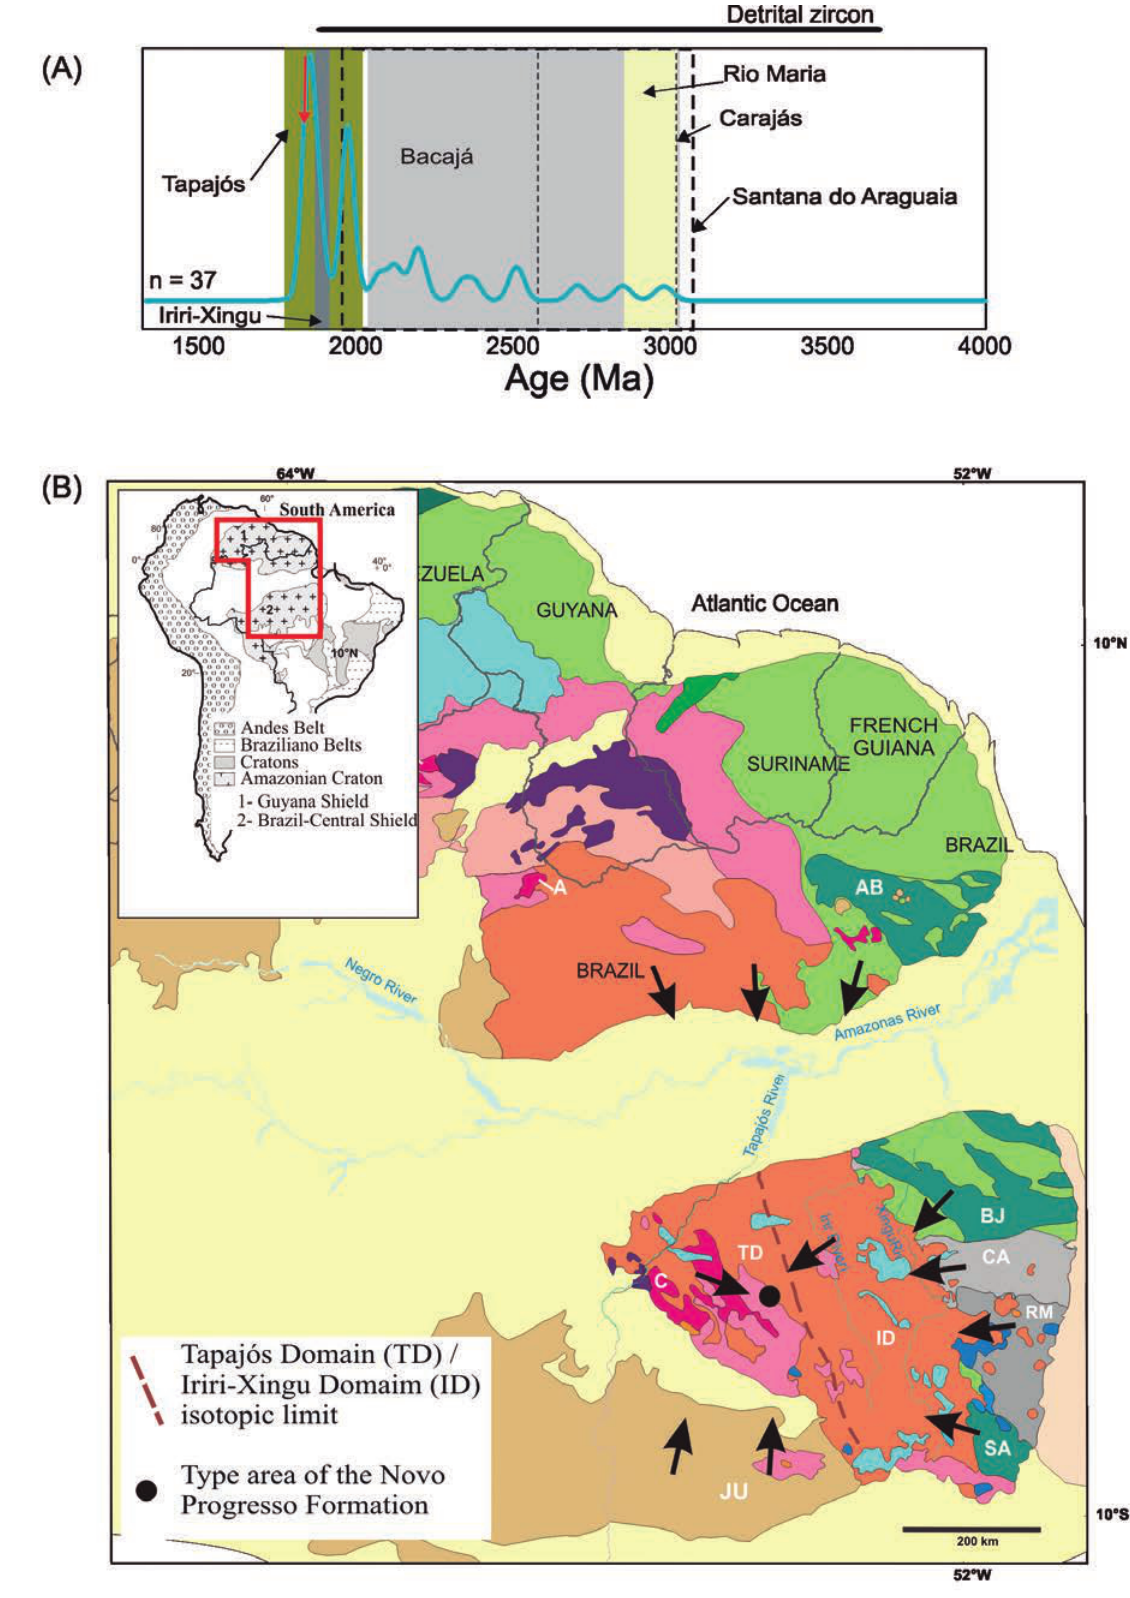
Figure 8 - (A) Probability density plot of detrital zircon ages for the Novo Progresso Formation displayed on the fields of ages of the magmatic events from tectonic domains of the central-southeastern portion of the Amazonian Craton. The upper thick bar shows the range of ages of detrital zircons from sedimentary basins within the same tectonic domains. Data compiled from Vasquez et al. (2008), Klein et al. (2012), Klein et al. (2014), Corrêa and Macambira (2014), Tavares (2015), and primary references in these works. (B) Simplified map of the Amazonian Craton with internal domains (modified from Fraga et al. 2017). Same legend as in Figure 1. The arrows show the potential source areas for the sediments of the Novo Progresso